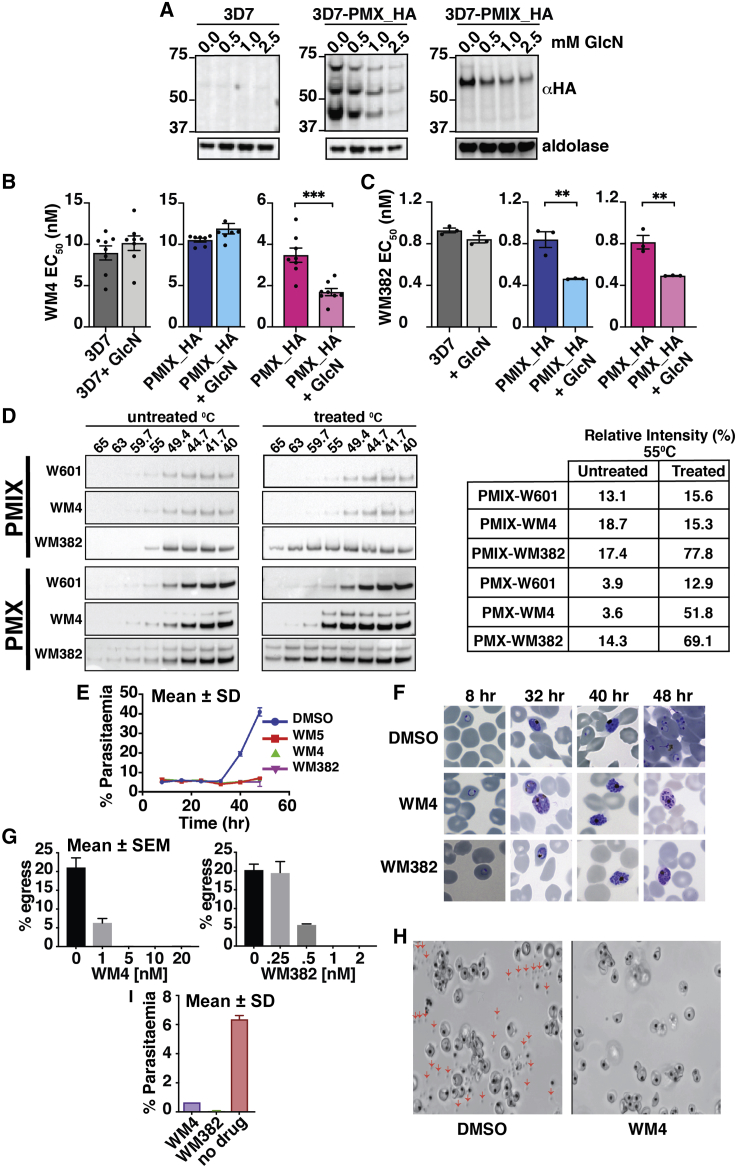
WM382 and WM4 Target Engagement, Parasite Growth, Egress, and Invasion(A) Knockdown of PMIX and PMX expression in P. falciparum using glms ribozyme and glucosamine (GlcN). 3D7, 3D7-PMX_HA, and 3D7-PMIX_HA treated with GlcN and probed with anti-HA.(B) EC50 for WM4 with P. falciparum in presence (light) and absence (dark) of 2.5 mM GlcN. Mean ± SD (eight experiments).(C) WM382 EC50 for P. falciparum in presence (light) and absence (dark) of 2.5 mM GlcN. Mean ± SE (five experiments).(D) CETSA with WM4 and WM382. Immuno-blots probed with αHA in 3D7-PMIX_HA and 3D7-PMX_HA. Right: relative intensity at 55°C.(E) Time of parasite killing for WM5, WM4, and WM382 in blood stage. DMSO, control. Mean ± SD.(F) P. falciparum-infected erythrocytes with DMSO, WM4, or WM382.(G) WM4 and WM382 block merozoite egress (percentage). Mean ± SEM.(H) Stills of schizonts visualizing egress (20 nM WM4). Arrows, free merozoites. Supplemental Information includes Video S1 (control with no drug) and Video S2 (plus 20 nM WM4).(I) Parasites grown in WM4 or WM382 are shown and percentage parasitemia. Mean ± SD.